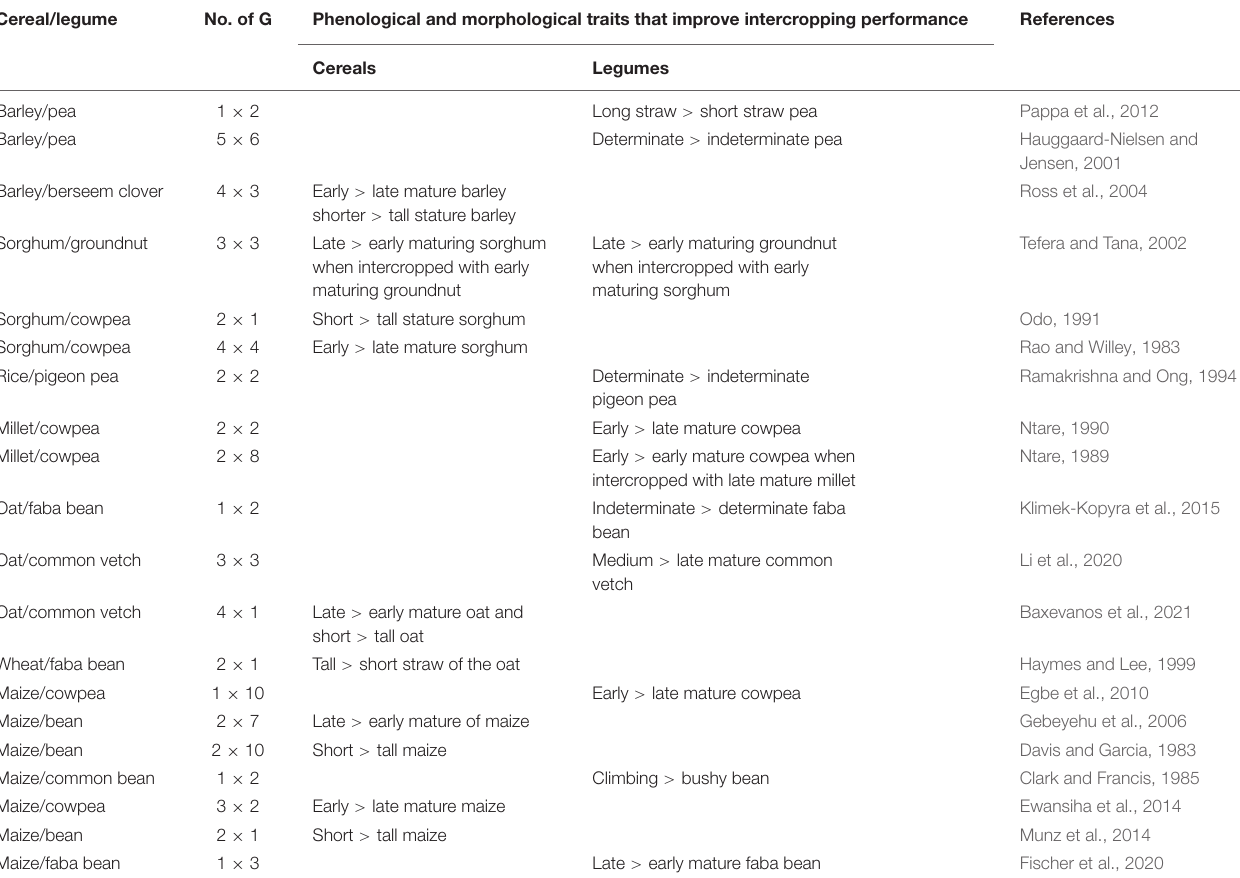
TABLE 6 | Mechanisms of genotypes (G) complementarity in cereal/legume intercropping as mentioned in the consulted literature. Cereal/legume No. of G Phenological and morphological traits that improve intercropping